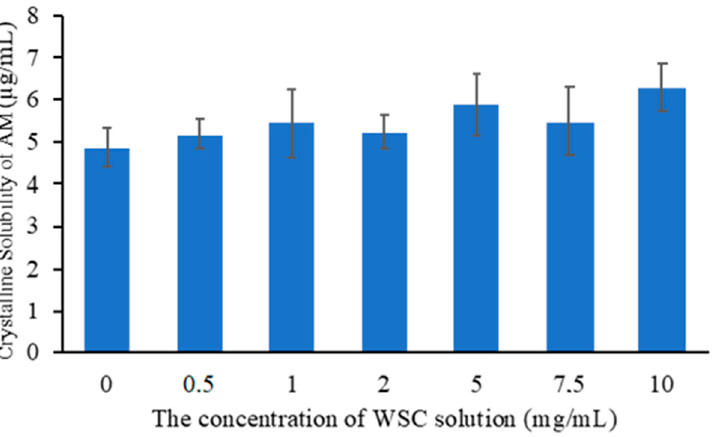
Figure 4. Crystalline solubility of AM at 25 °C in WSC solution with various concentrations.